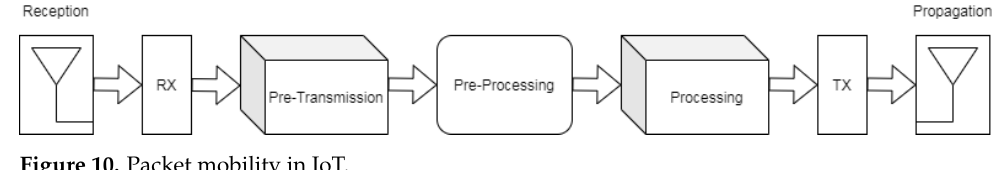
Figure 10. Packet mobility in IoT.